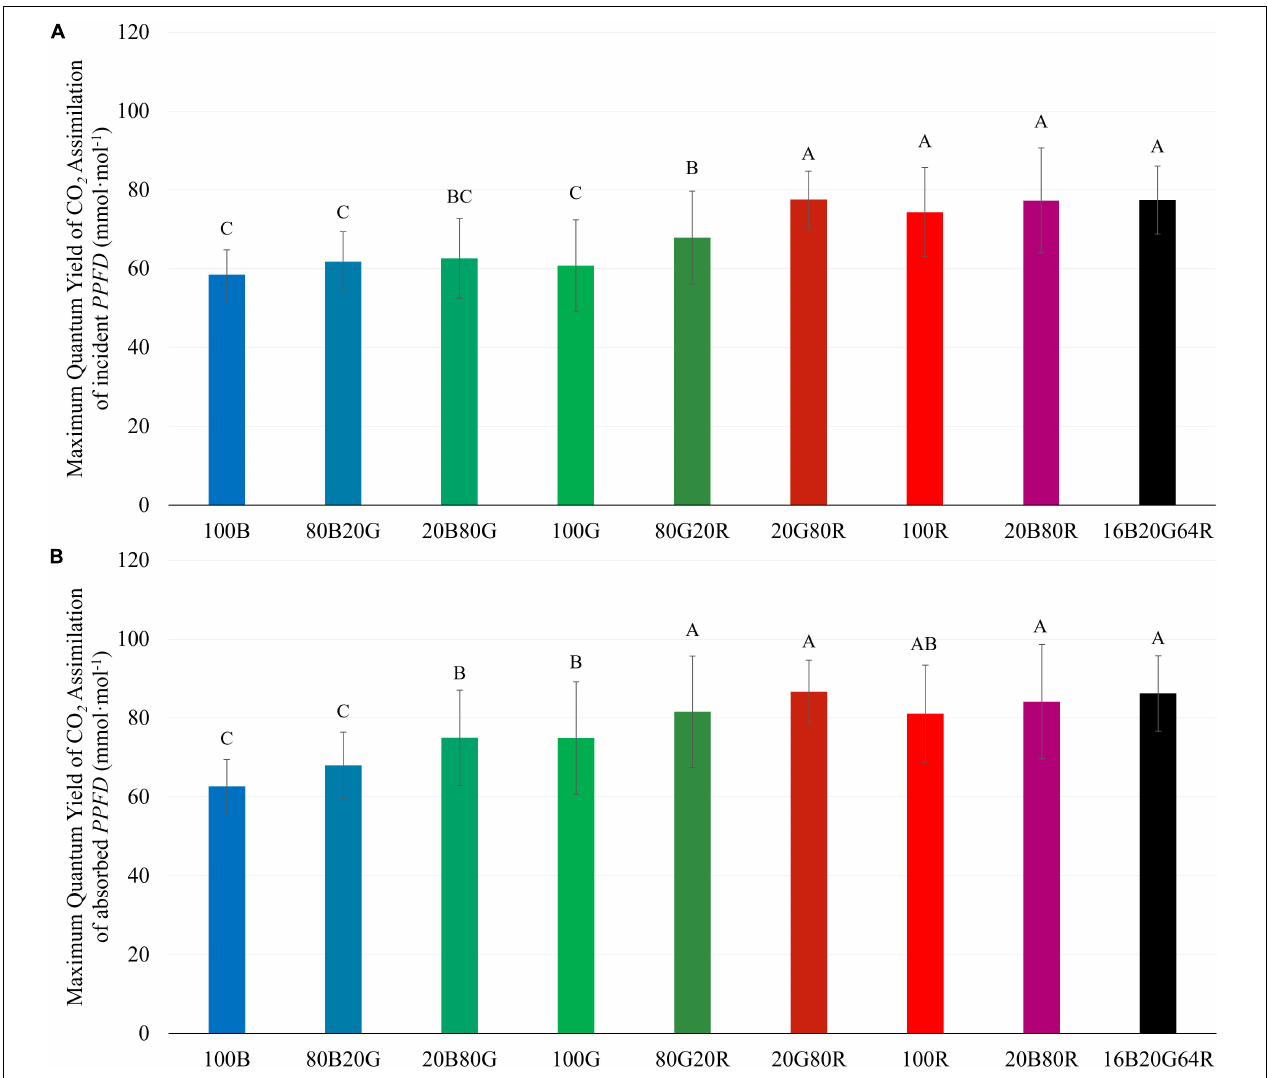
FIGURE 4 | Maximum quantum yield of CO 2 assimilation of “Green Towers” lettuce based on incident ( QY m , inc ) (A) and absorbed light ( QY m , abs ) (B) under nine different light spectra. Values are calculated as the initial slope of the light response curves of corresponding light spectra (see Figure 3 ). Bars with the same letter are not statistically different ( p ≤ 0.05). Error bars represent the standard deviation ( n = 9). The composition of the nine light spectra is shown in Table 1